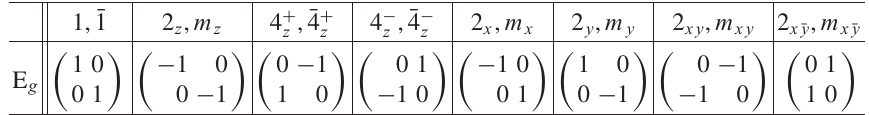
Table 2. Matrices of the irrep E g of the point group 4 /mmm for a certain choice of the basis in the irrep space.